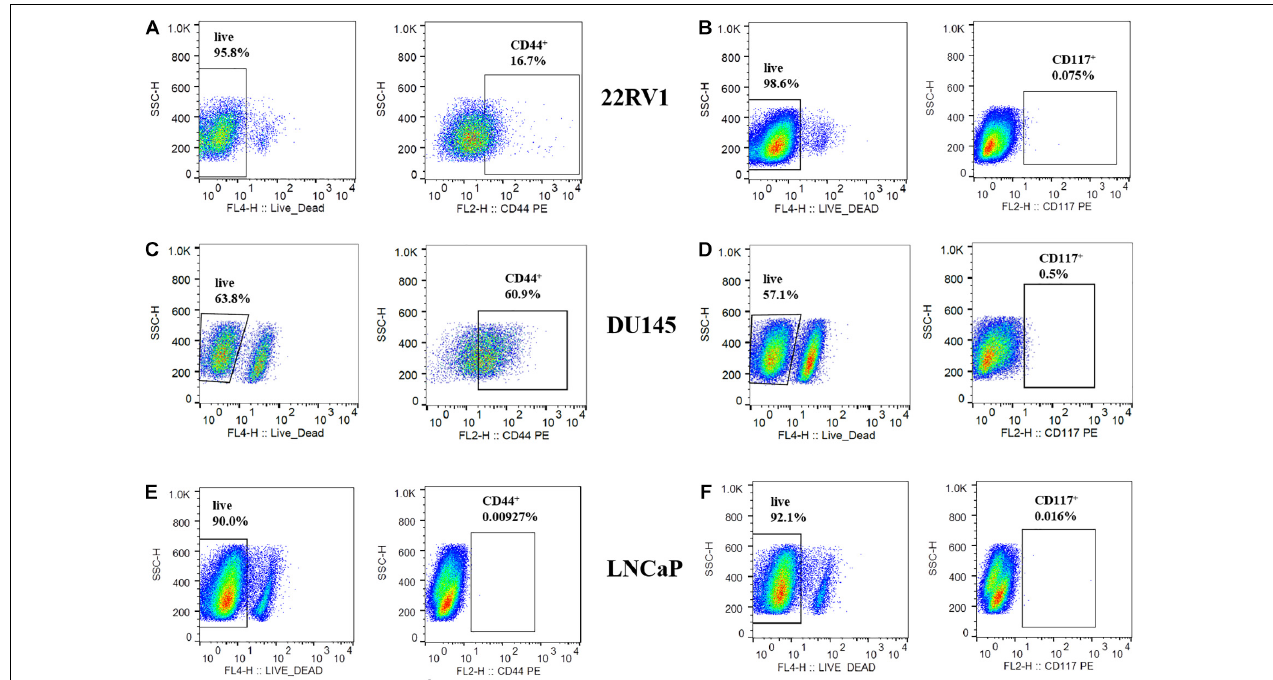
FIGURE 2 | Detection of CD44 and CD117 markers in PCa spheroids by flow cytometry. (A,C,E) Population of CD44 + cells in 3-day old 22RV1, DU145 and LNCaP spheroids, respectively, gated on live cells. (B,D,F) Population of CD117 + cells in 3-day old 22RV1, DU145 and LNCaP spheroids, respectively, gated on live cells.